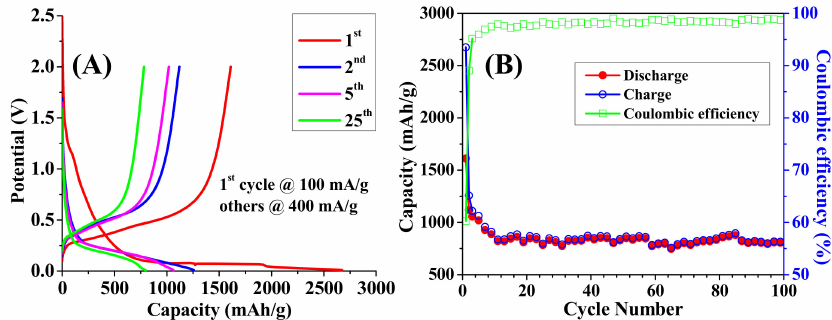
Figure 3. SiNT battery performance: ( A ) galvanostatic discharge–charge profiles; ( B ) cycling